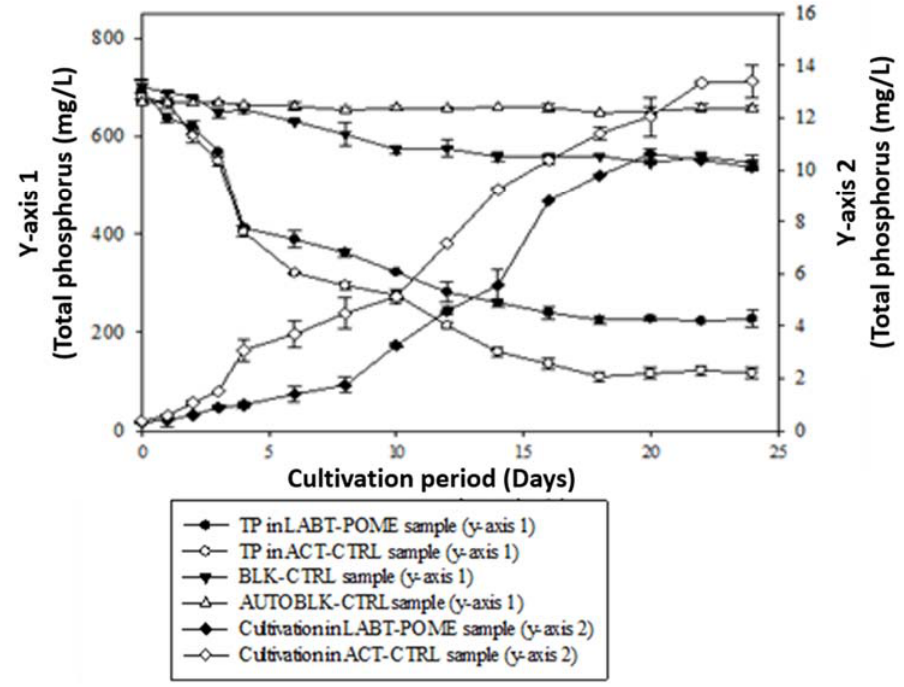
Figure 5. Reduction of soluble chemical oxygen demand (SCOD) from LABT-POME using Chlorococcum oleofaciens .